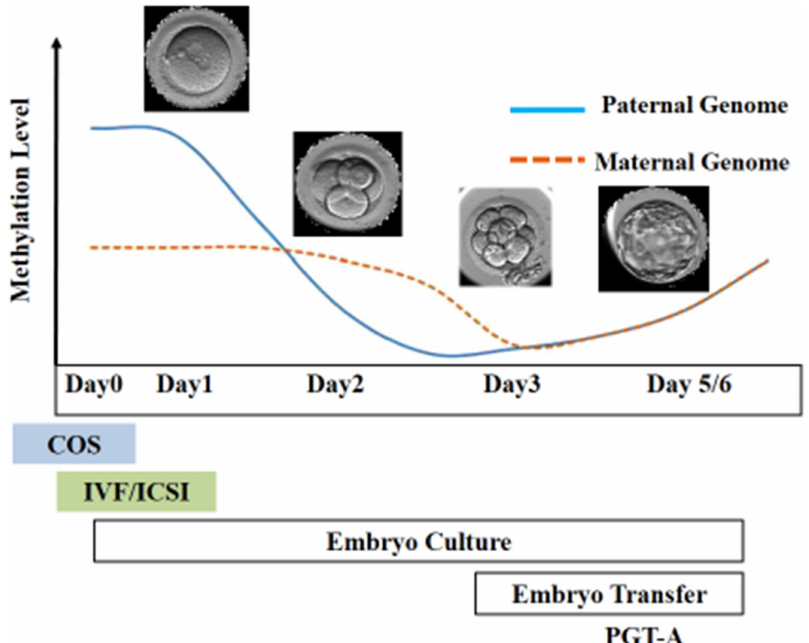
Figure 1. DNA methylation and epigenetic reprogramming during the early stage of embryo de- velopment. The paternal genome undergoes active demethylation post-fertilization, whereas the maternal genome is passively demethylated.